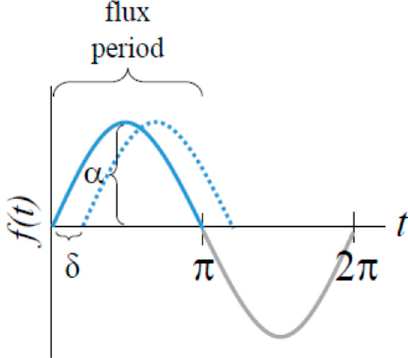
Figure 3. A sine wave, f ( t ) = sin( t ), 0 ≤ t ≤ 2 t , was used to represent the hydrologic flux over time. Conceptually only half of a full period, 0 to t (solid line) was used to represent the snowmelt season, and the discharge was then described relative to the snowmelt season.